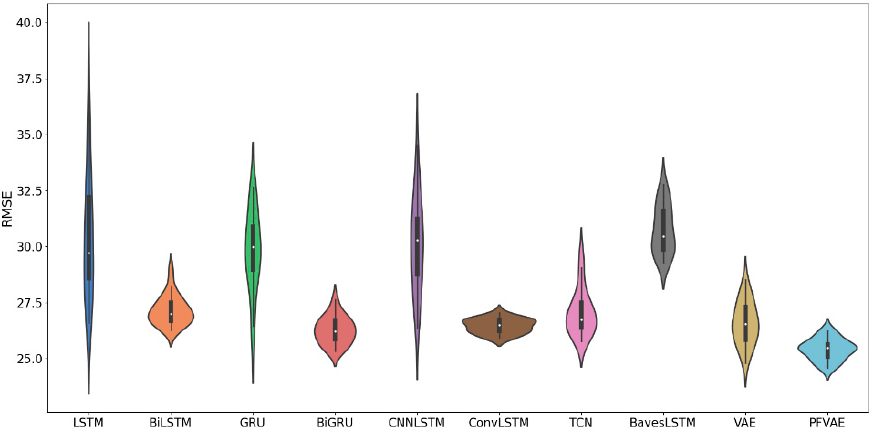
Figure 6. RMSE violin plots for each model run 20 times on the PM2.5 dataset.